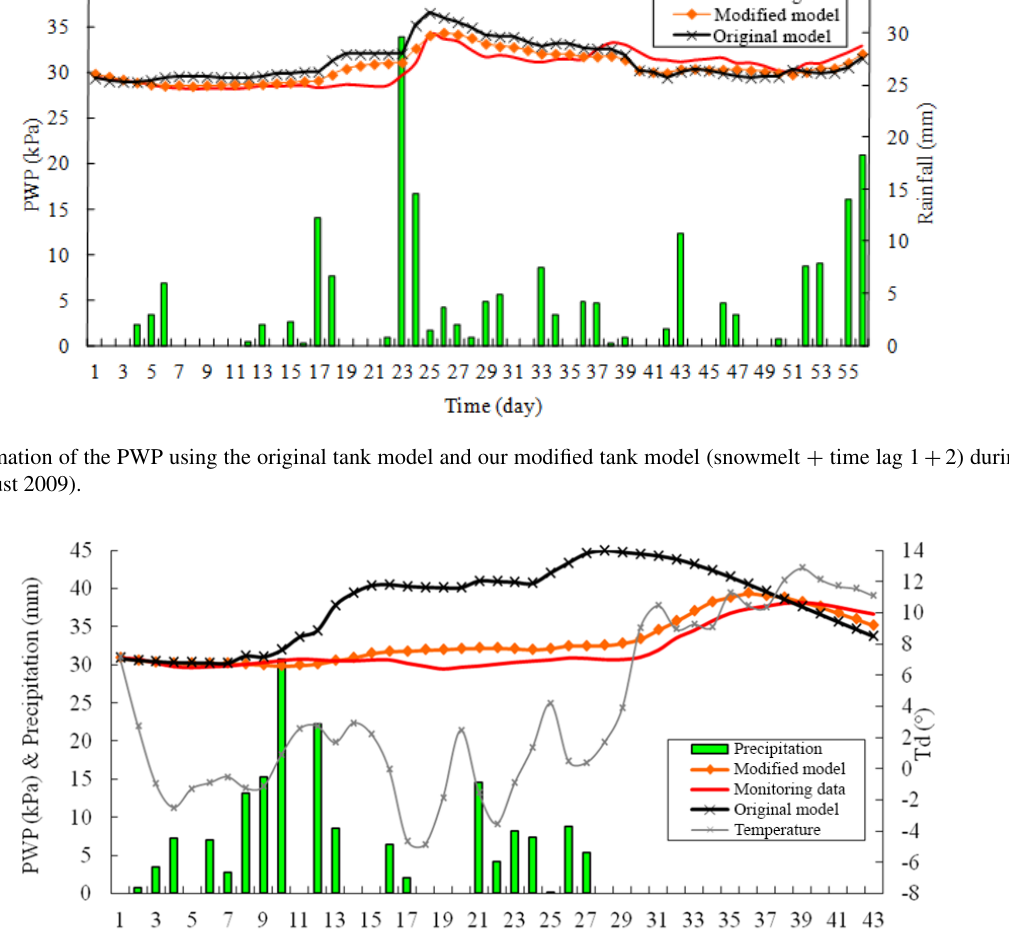
Figure 12 indicates evaluation index of original and modi- fied tank model including correlation, root mean square error (RMSE) and relative